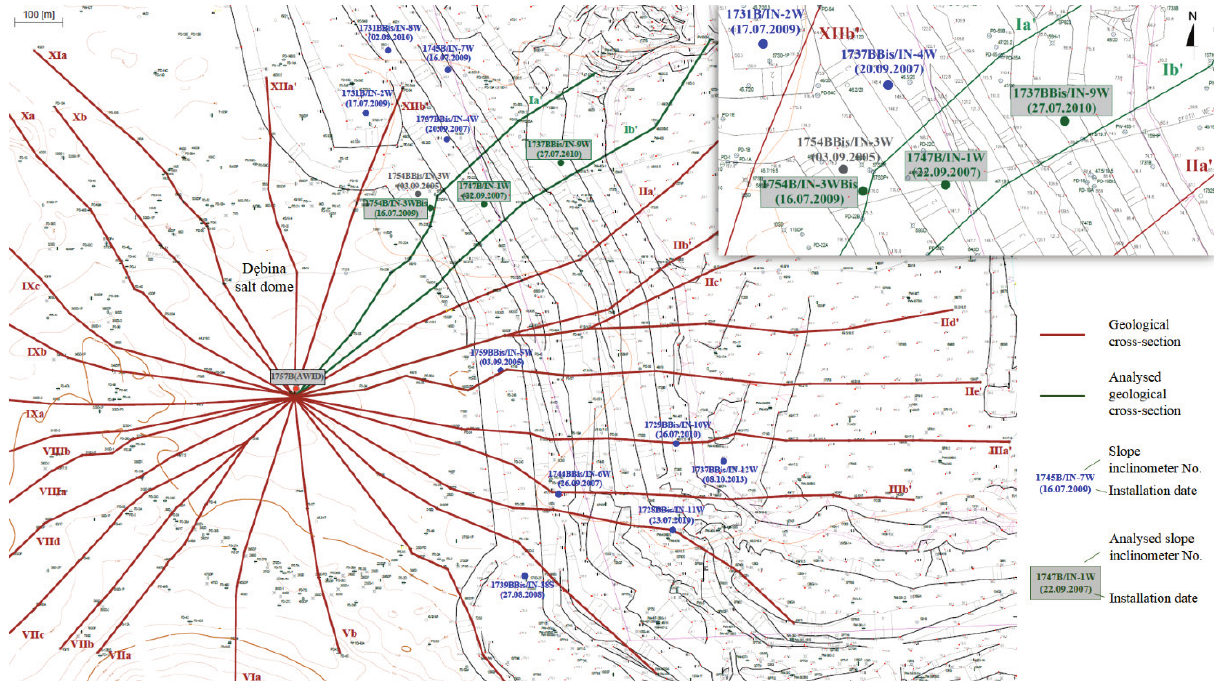
Fig. 4. The slope inclinometers distribution and location of cross-sections in the Bełchatów western slope (based on [2]) Table 1. The basic information about inclinometers installed on the Bełchatów western slope (based on [2]) Inclinometer